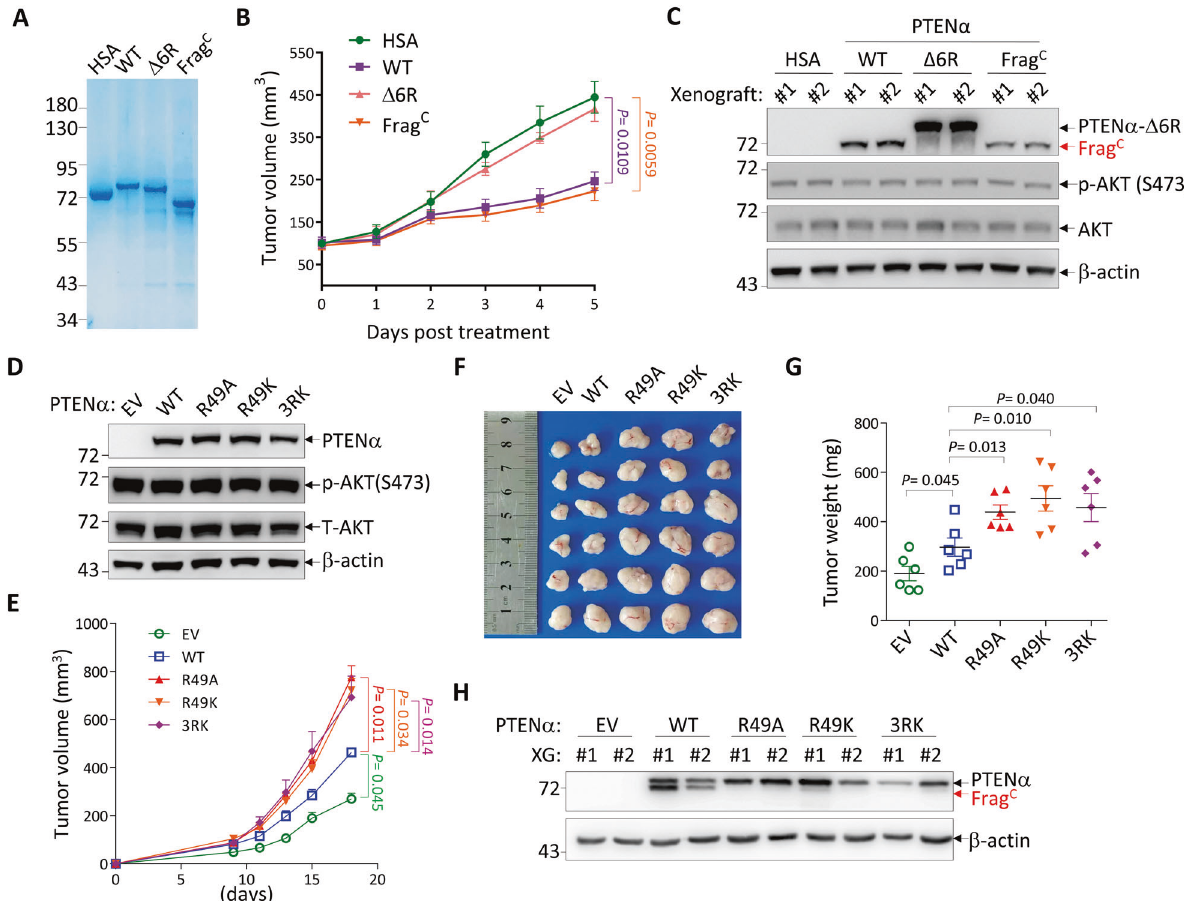
Fig. 5 The C-terminal fragment of PTEN α exerts a tumor-suppressive role. A HSA and bacterially puri fi ed PTEN α derivatives were visualized by Coomassie blue staining. B , C PTEN -knockout SMMC-7721 cells were subcutaneously injected into nude mice (1.5 × 10 6 cells per mouse). After tumors reached approximately 100 mm 3 in volume, HSA and PTEN α derivatives were intratumorally injected (10 μ g/day for 6 days) and tumor volumes were monitored ( B ). Two tumors from each group were randomly selected for Western blot analysis for the indicated proteins ( C ). Data in B are presented as the mean ± SEM, n = 5 biologically independent samples. Statistical signi fi cance was determined by two-way ANOVA with P values shown. D – H PTEN -knockout SMMC-7721 cells expressing EV or PTEN α derivatives ( D ) were subcutaneously injected into nude mice (1.5 × 10 6 cells per mouse) and tumor volumes were measured at different days (E). On day 18 after subcutaneous injection, tumors were harvested, photographed ( F ) and weighted ( G ), and two tumors from each group were randomly selected for Western blot analysis for the indicated proteins ( H ). Data in E and G are presented as the mean ± SEM, n = 6 biologically independent samples. Statistical signi fi cance was determined by two-way ANOVA ( E ) and two-tailed unpaired t -test ( G ) with P values shown. HSA Human Serum Albumin, EV empty